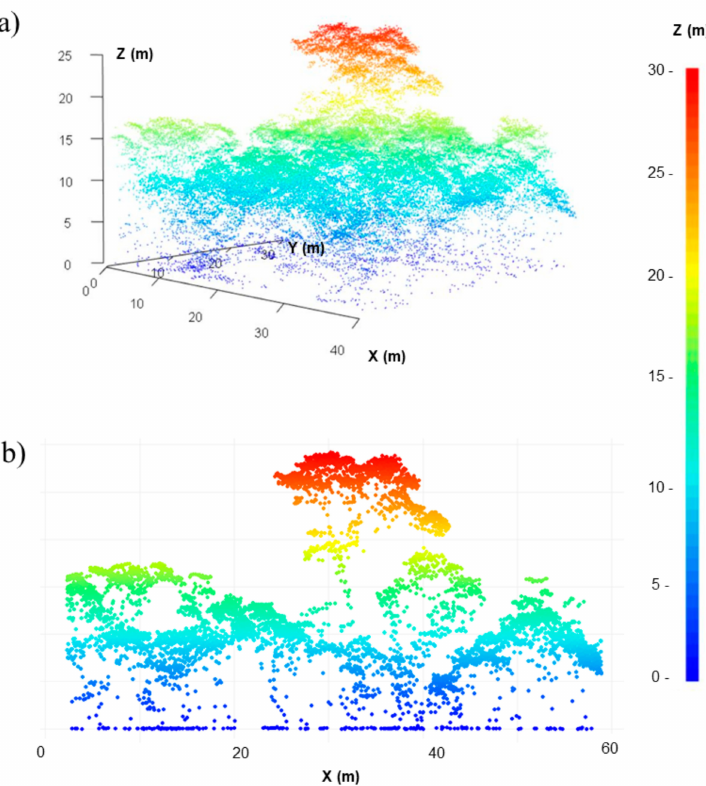
Figure 2. Airborne laser scanner (ALS) point cloud representing the vertical structure of a plot of the Ponte Branca forest remnant. ( a ) Three-dimensional view of the plot. ( b ) Cross-section of the same